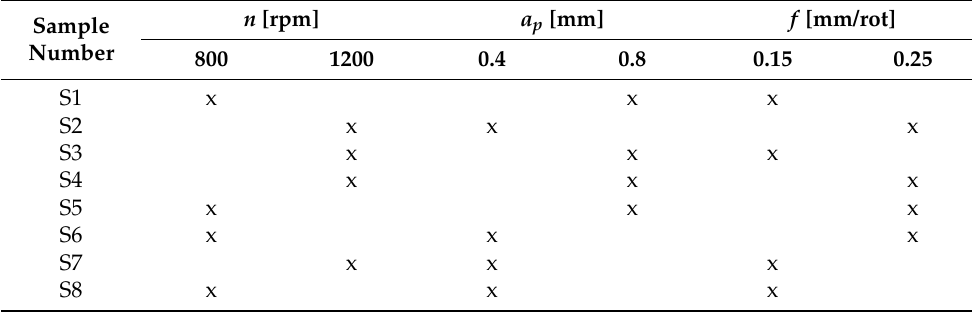
Table 3. Programming experiments through the method of factorial experiments.